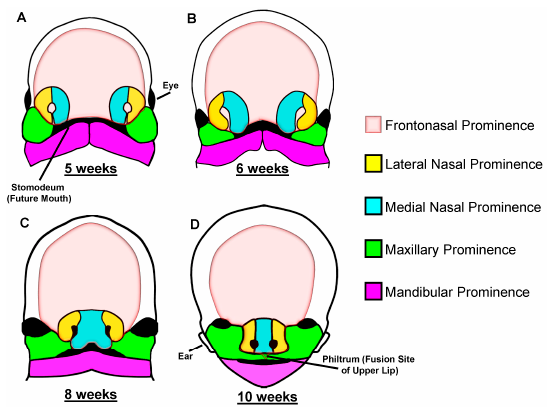
Figure 1. Schematic diagram of human facial development. The craniofacial skeleton is predominantly made up of five primordia; the frontonasal prominence (FNP; including the lateral and medial nasal prominences), paired maxillary (MX), and paired mandibular (MD) prominences. These gradually migrate towards the midline, to form the nose, lips and jaws, and are fully integrated by 10 weeks of human embryonic development. The MD processes appose and fuse first (at ~5 weeks of age; ( A ), followed by fusion of the lateral MX prominences with the medial and lateral nasal processes in the ventrolateral FNP ( B ). Next, fusion of both medial nasal prominences forms the midline of the nose and the primary palate ( C ). Two outgrowths of the MXP (the palatal shelves) elevate and migrate towards each other, fusing with each other and the primary palate to form the upper jaw ( D ). Adapted from